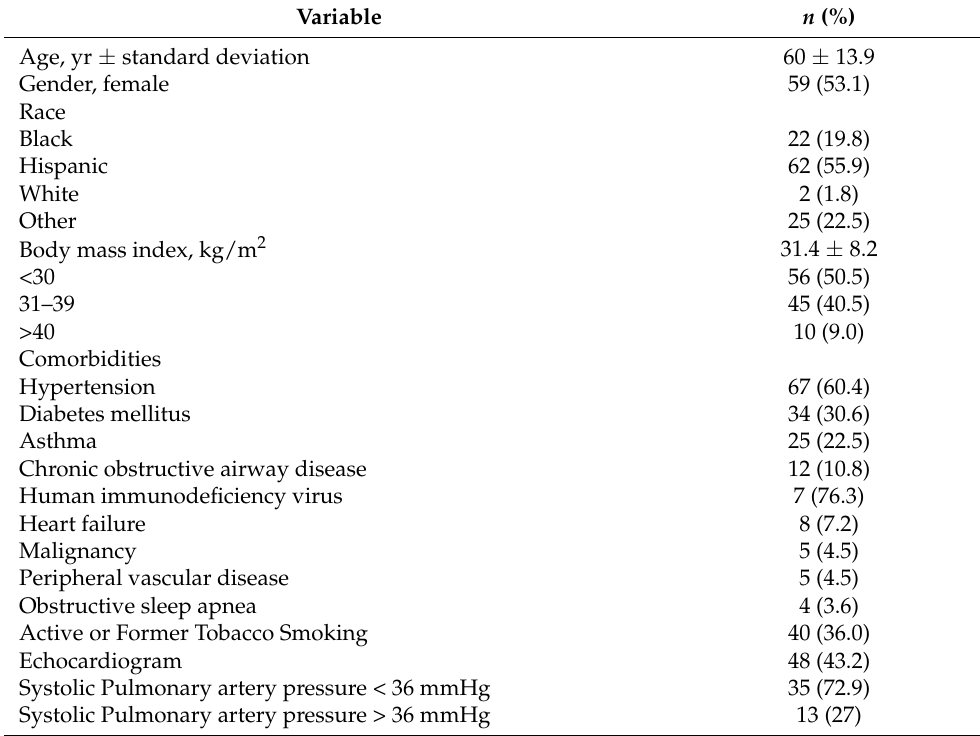
Table 1. Clinical characteristics of patients with post-COVID-19 pneumonia.